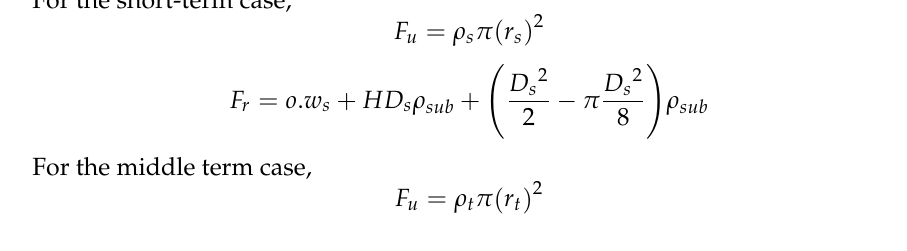
For the middle term